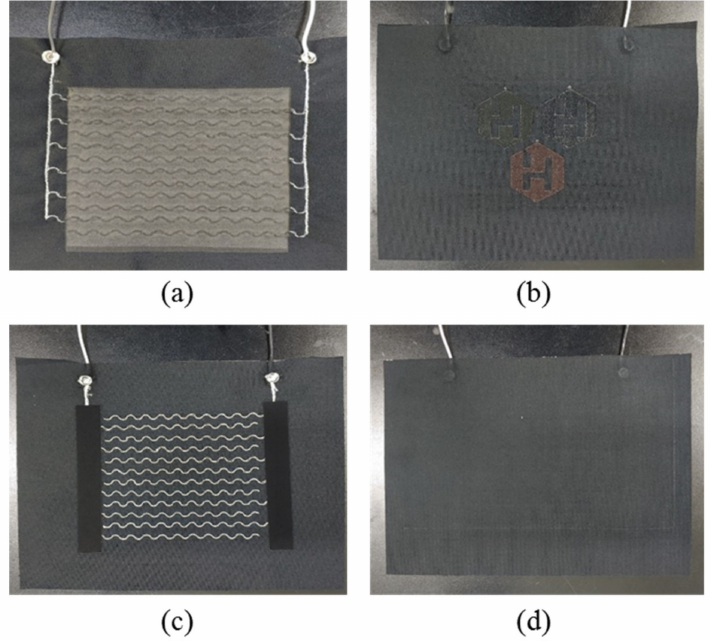
Figure 5. Digital photographs of the front: ( a ) after screen-printing; ( b ) finished product and back ( c ) after screen-printing; ( d ) finished product of the